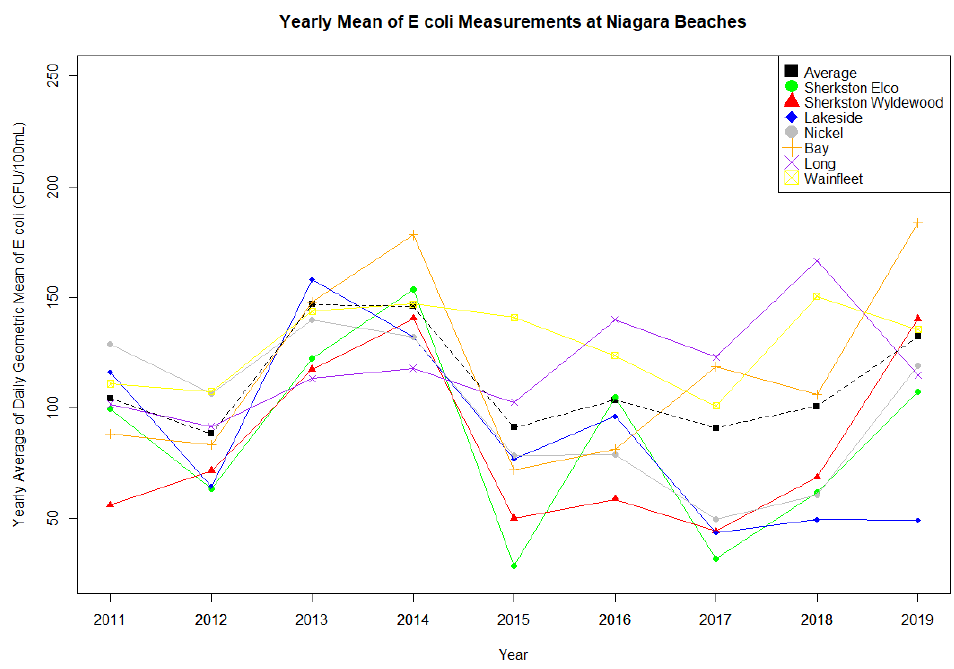
Figure 3. Mean annual E. coli geometric mean at Niagara Region Beaches, 2011–2019. Figures 4 and 5 present the percentage of days per season that each region exceeded